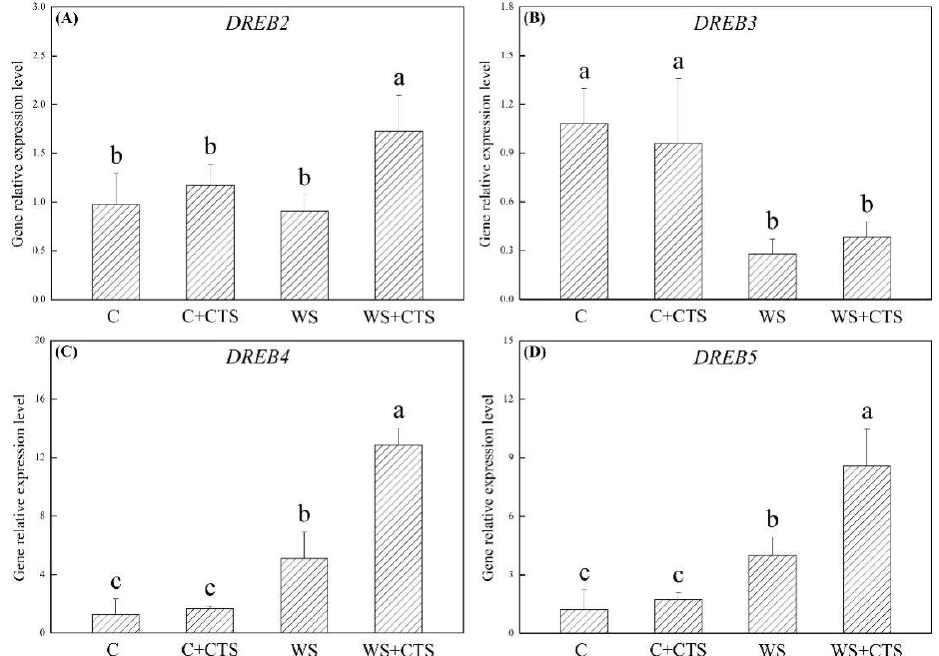
Figure 6. Seeds priming with chitosan affected genes expression levels of ( A ) DREB2 , ( B ) DERB3 , ( C ) DREB4 , and ( D ) DREB5 encoding different types of dehydration responsive element-binding proteins in seedlings after 7 days of germination under water stress. Vertical bars above columns